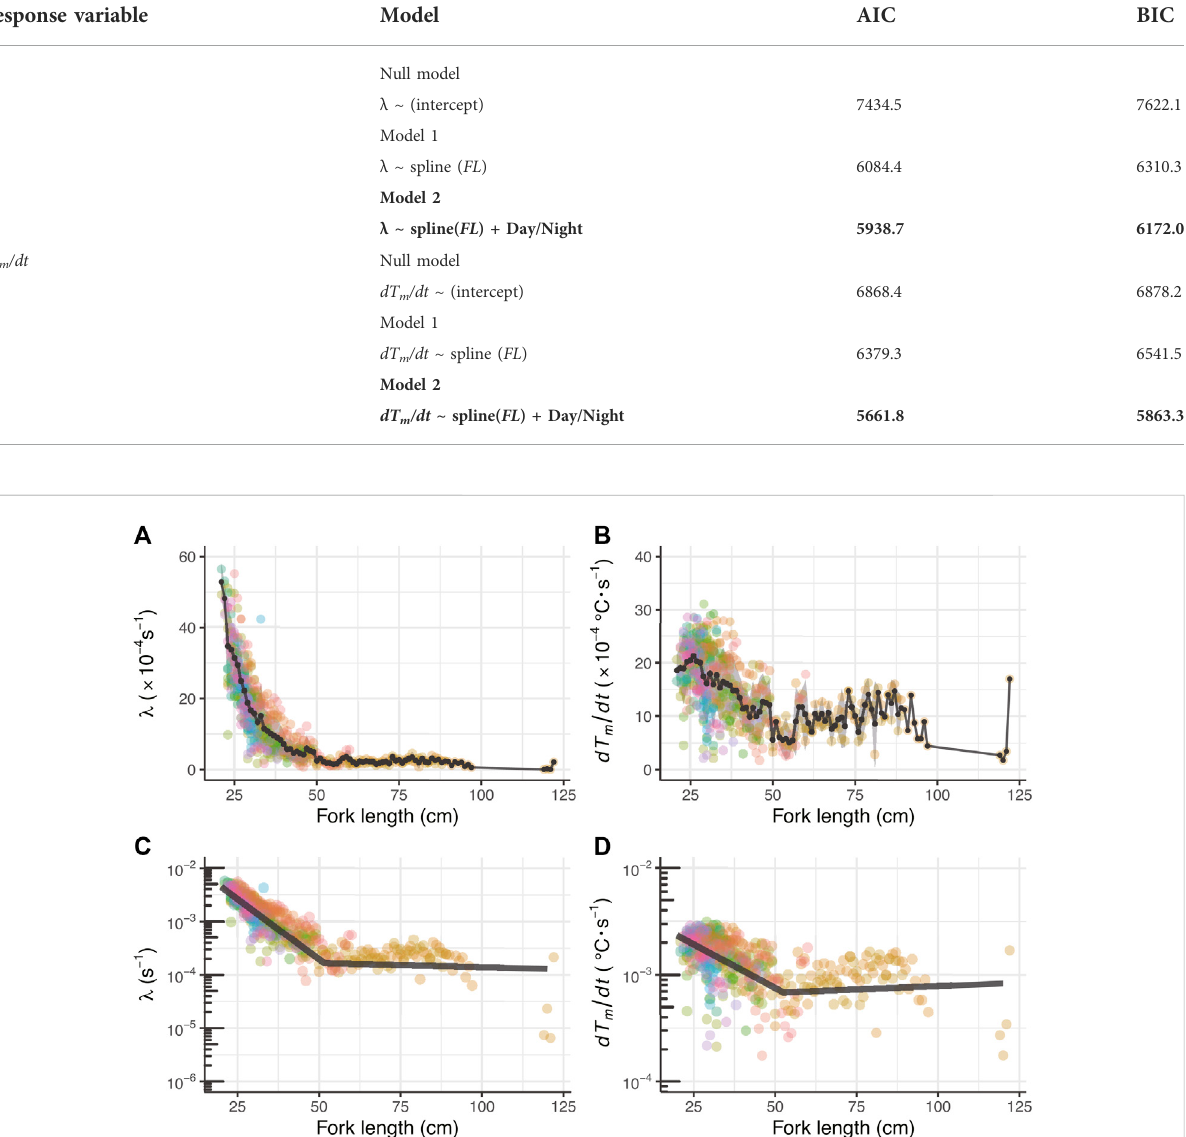
TABLE 2 Effect of day/night on the heat-budget model parameters ( λ and dT m /dt ) using the generalized additive mixed model. The best- fi tting models are indicated in bold. Random effect was modeled as the intercept.